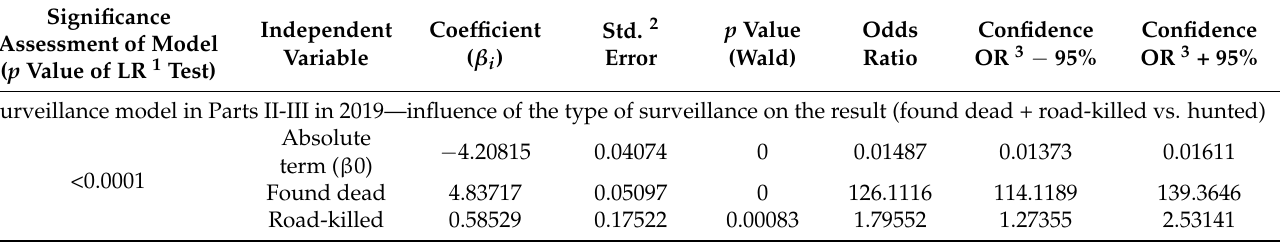
Table 4. Results logistic regression models. Surveillance model in Parts II-III in 2019.